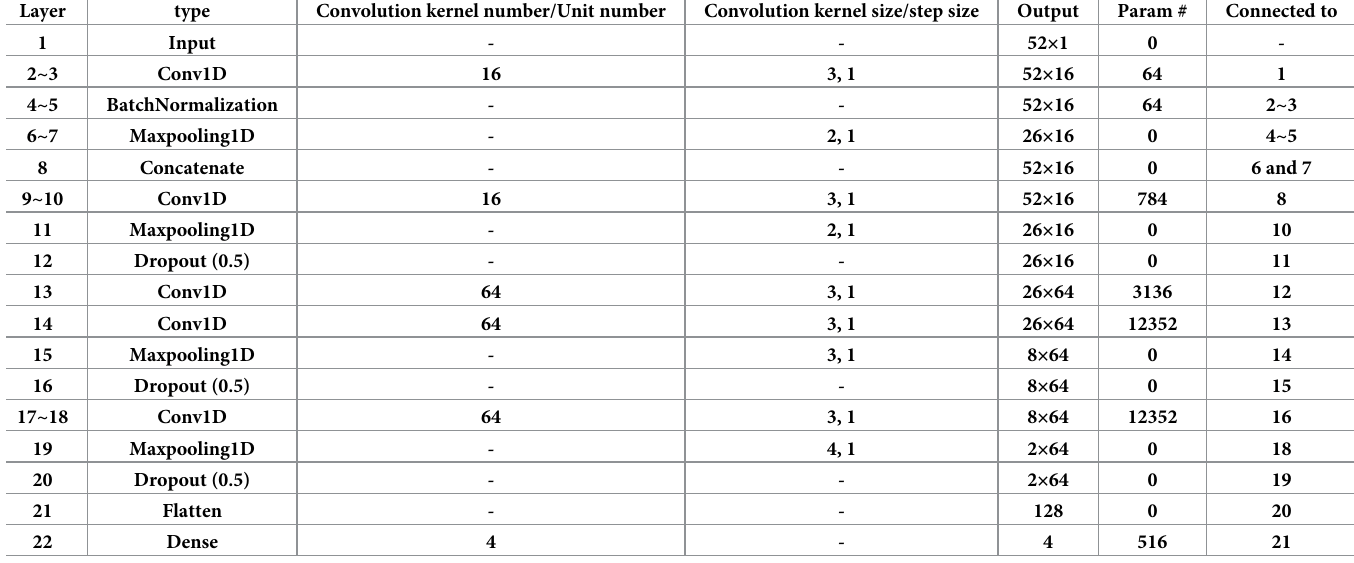
Table 3. Detailed parameters of the classification network at CR =